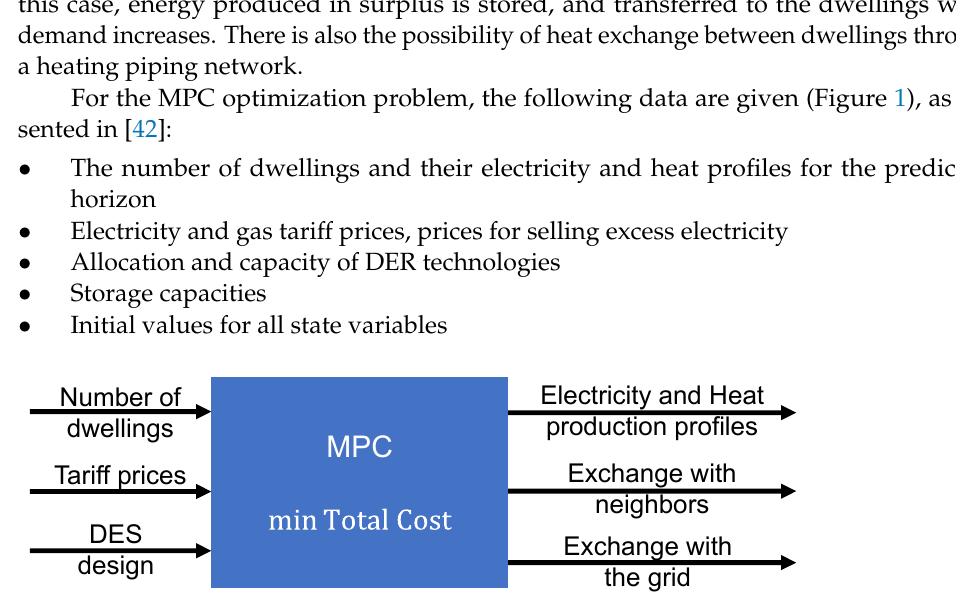
Figure 1. Inputs and outputs of the MPC optimization problem.